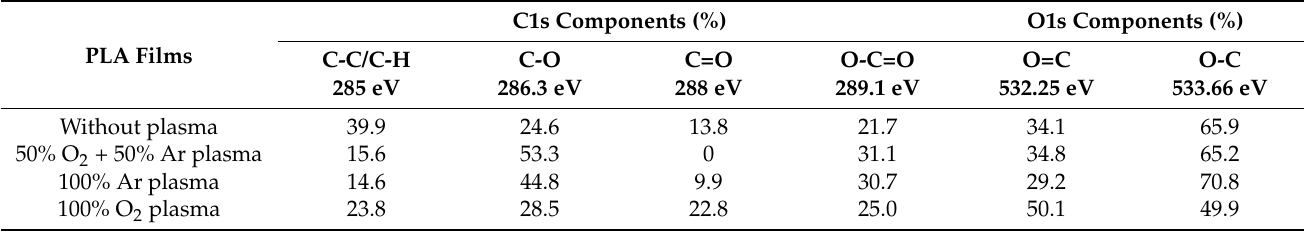
Table 1. Various components (in area %) of Cls and Ols peaks of XPS spectra of PLA films untreated and plasma treated with different gas